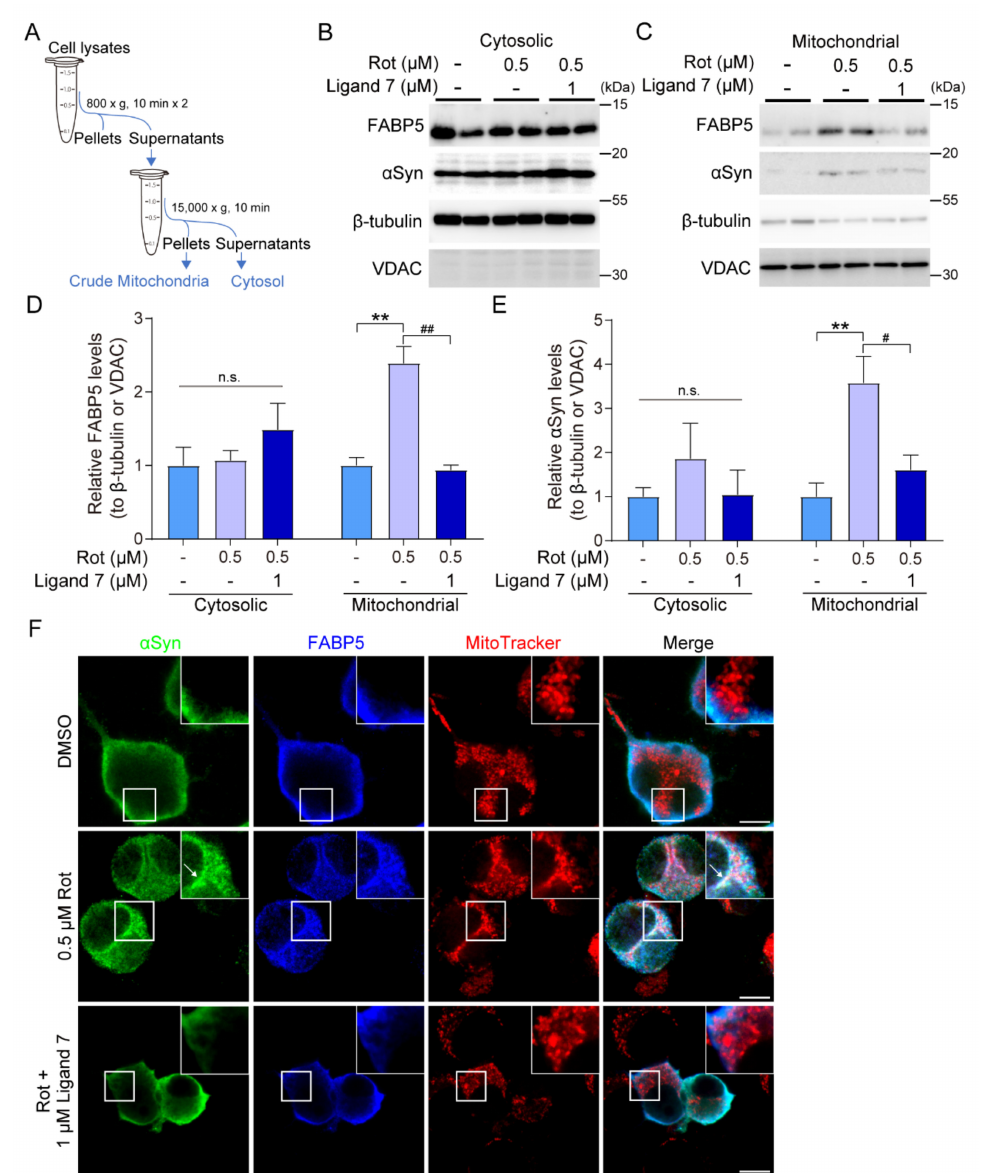
Figure 6. Abnormal accumulation of FABP5 and α Syn in mitochondria was prevented by ligand 7 treatment. All experiments were carried in α S/F5 -transfected cells. ( A ) Simple diagram of the mitochondrial isolation process in α S/F5 -transfected cells. ( B , C ) Representative images of immunoblots probed with antibodies against FABP5 and α Syn. Incubation with anti- β - tubulin or VDAC antibodies were used as protein-loading controls for cytosolic or mitochondrial fractions, respectively. ( D , E ) Quantitative densitometric analyses of α Syn and FABP5 in different fractions. Results are presented as means ± SEM (n = 4, two respective cell experiments, each with 2 parallel dishes). ** p < 0.01, vs. non-rotenone-treated cells; # p < 0.05 and ## p < 0.01, 1 µ M vs. rotenone-treated cells without ligand. ( F ) Confocal images of α Syn (green), FABP5 (blue), and MitoTracker (red) in α S/F5 -transfected cells. The region of interest is indicated with a white square and magnified in insets. Arrow indicates α Syn aggregates which approach and gather in mitochondria with FABP5 in rotenone-treated cells. There were no significant α Syn- and FABP5-positive aggregates in mitochondria of ligand 7-treated cells. Scale bars: 10 µ